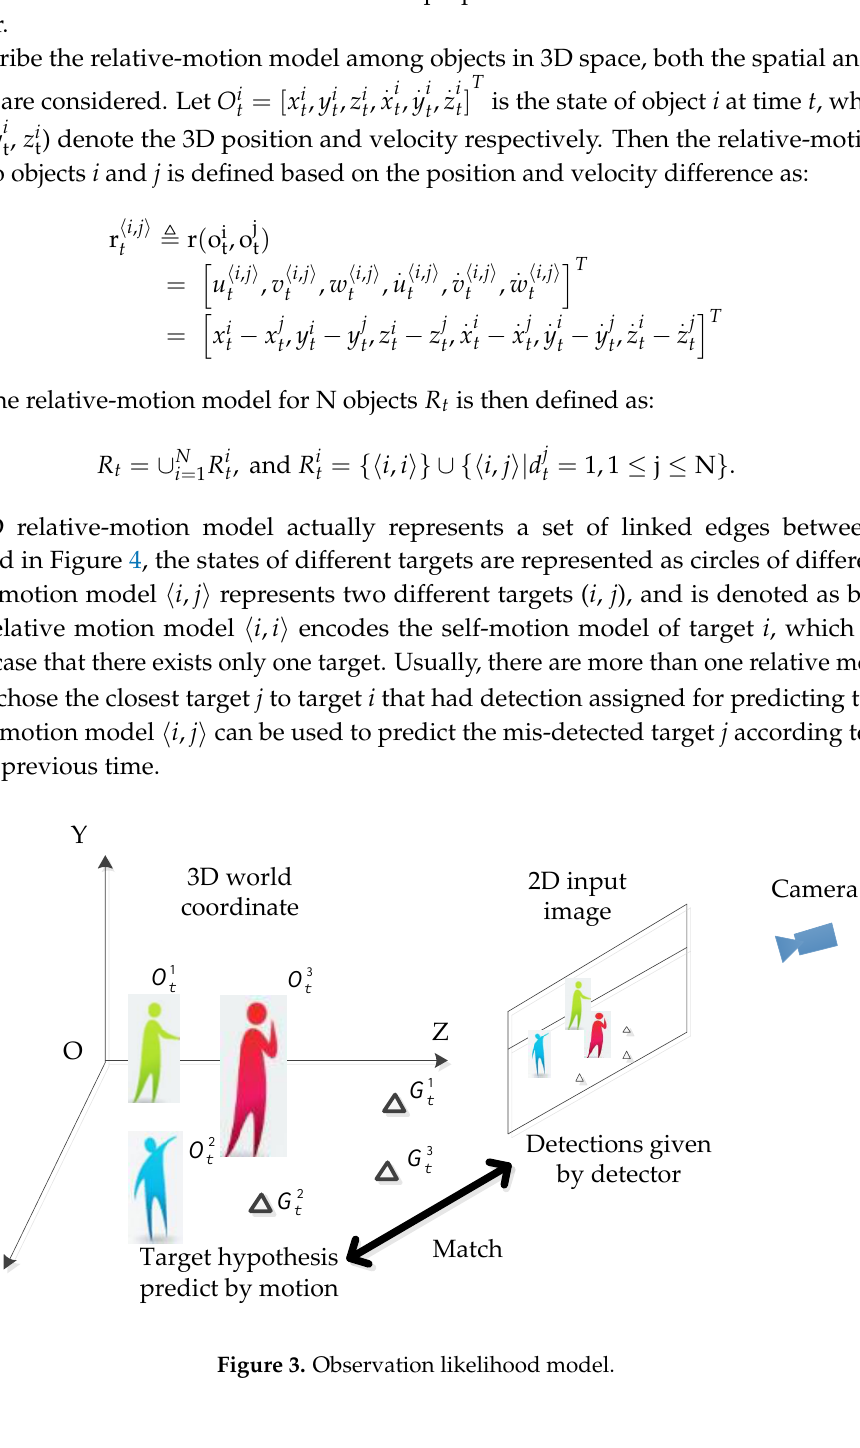
Figure 4. Predicting the target state with the relative-motion model. For both relative-motion models and the previous targets’ states, the motion transition is expressed by: